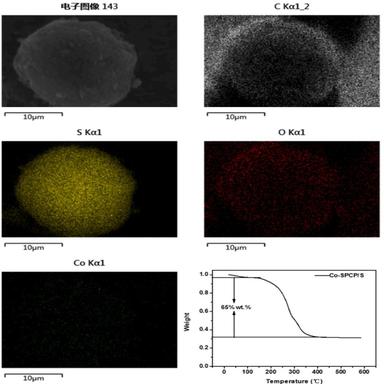
SEM image of Co-SPCP/S (a) with the EDS elemental mapping images of carbon (b), sulfur (c), oxygen (d) and cobalt (e) and the TGA curve of the Co-SPCP/S sample (f).